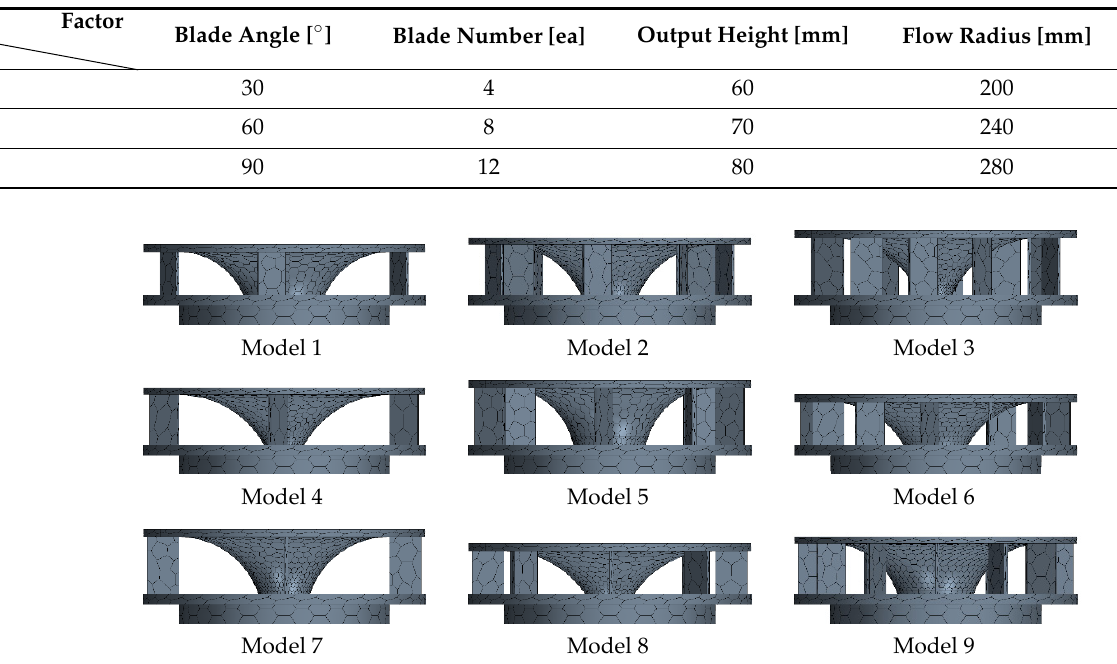
Figure 4. Outlet model with L9 applied.